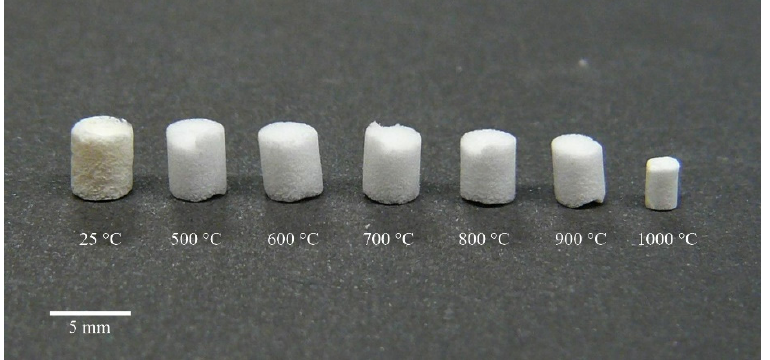
Figure 1. Demonstration of the effect of sintering temperature on the dimensions of cylindrical specimens. Scale bar: 5 mm.